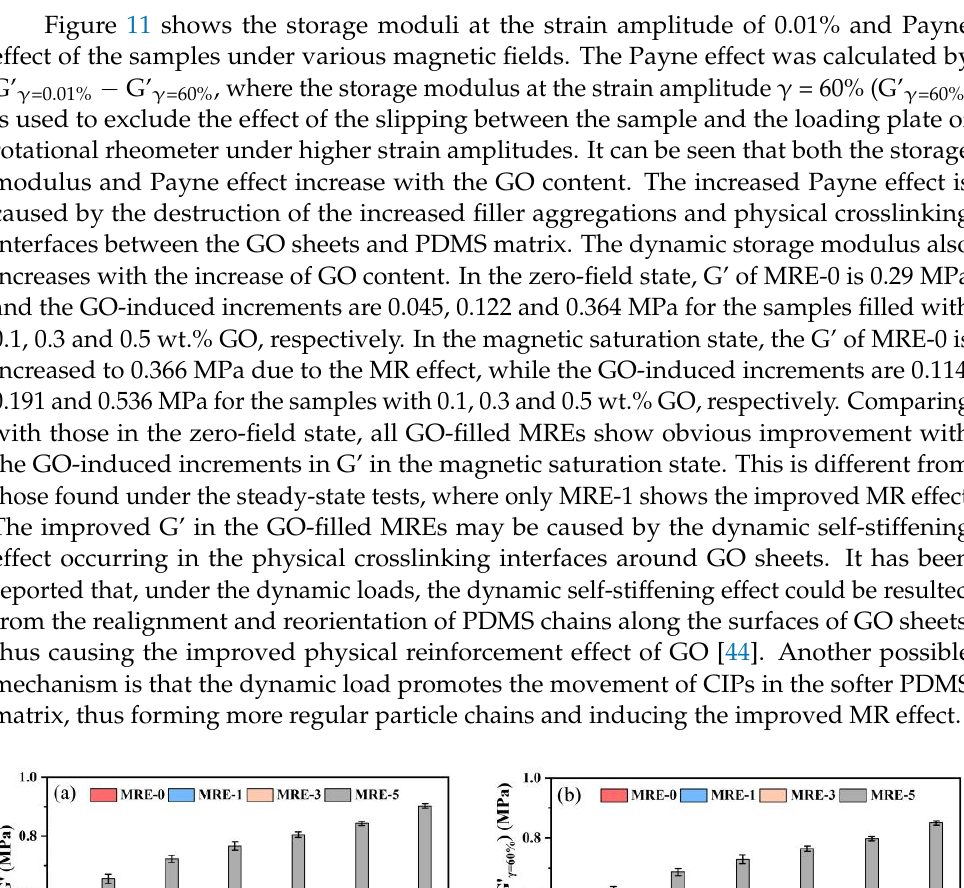
Figure 10. The strain amplitudes at tan(δ) = 1 of the MREs.